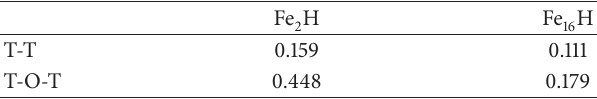
Table 6: Diffusion barrier of hydrogen in pure iron, eV.